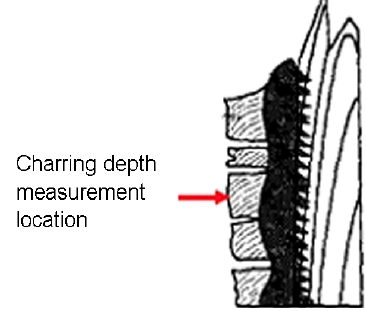
Fig. 2. Measurement of charring depth